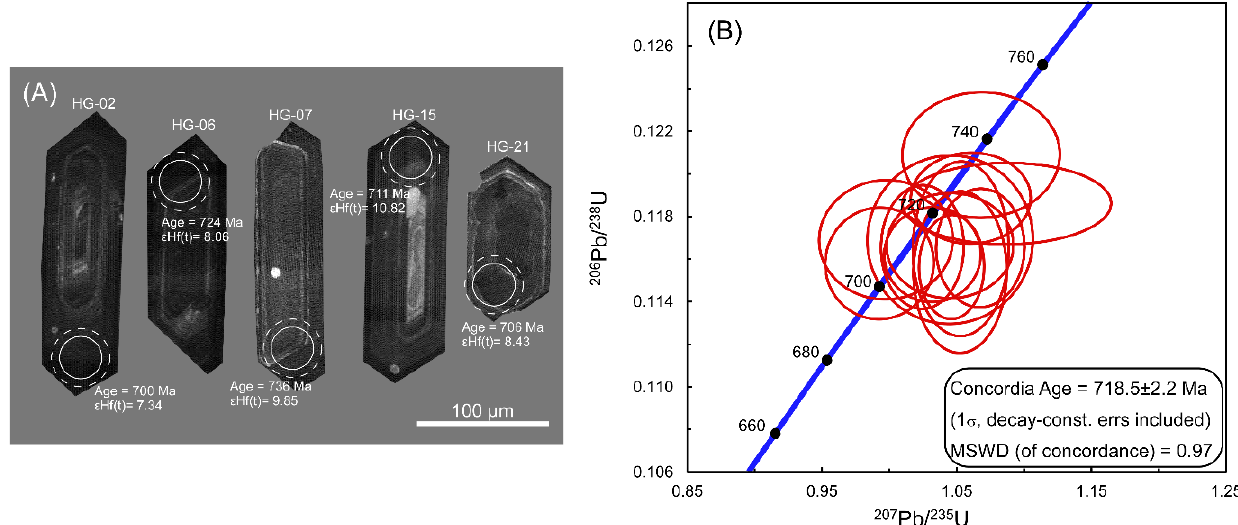
Figure 3. ( A ) Cathodoluminescence (CL) images of representative zircon grains of the Haweit granodiorites, showing inner structures and the laser analytic spots, 206 Pb/ 238 U ages, and ε Hf(t) values. Solid white circles show the locations of U-Pb age analyses, and dotted circles show the locations of Lu-Hf isotope analyses; ( B ) zircon U-Pb Concordia diagram for the analyzed